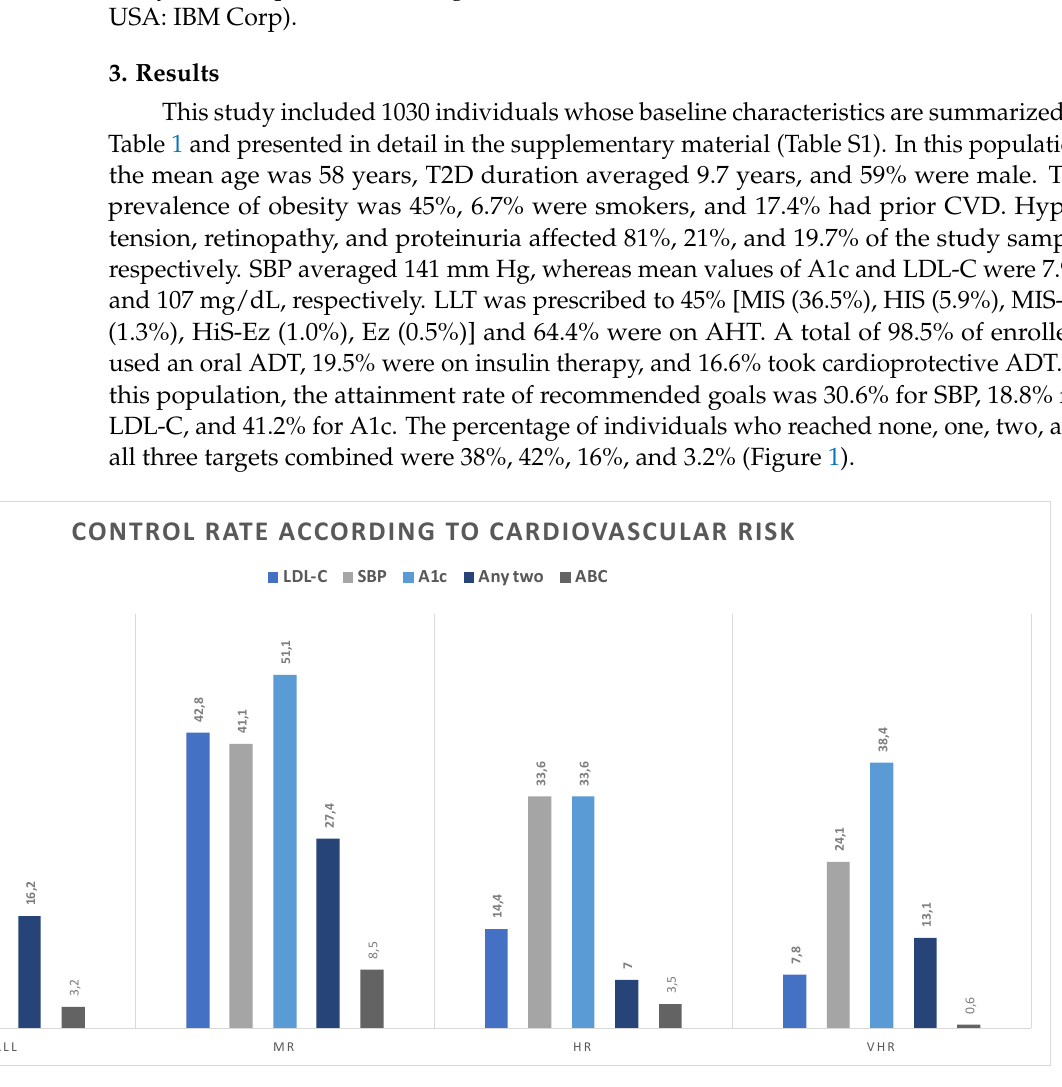
Figure 1. Control rate according to the risk factor and baseline cardiovascular risk. MR, moderate risk; HR, high risk; VHR, very high risk; T2D, type 2 diabetes; SBP, systolic blood pressure; A1c, glycated hemoglobin; ABC, HbA1c, blood pressure, and LDL-C targets combined. Patients were then grouped according to their baseline CVR as MR (30.5%), HR (15%), and VHR (54%). Compared to MR and HR individuals, VHR individuals showed longer T2D duration, were older, less educated, and had lower family income (Table 1).